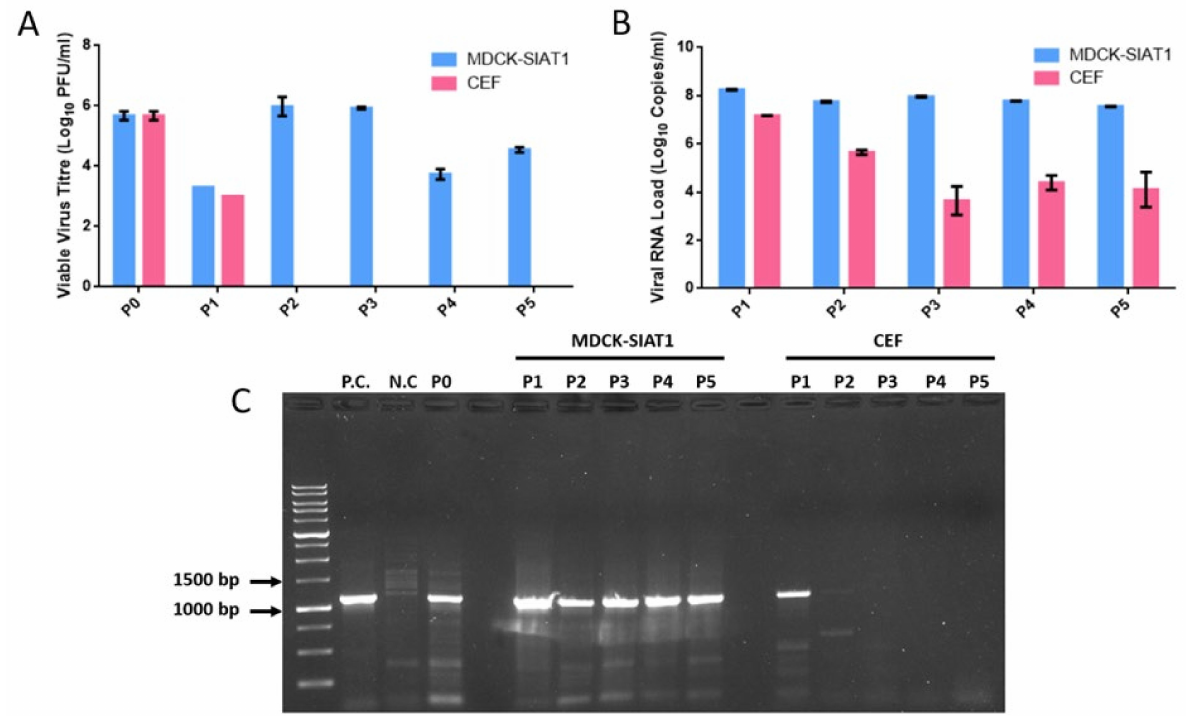
Figure 2. Viable A/Singapore/G2-31.1/2014 virus, total viral RNA quantification, and classical HA1 RT-PCR amplification of serial passage samples. ( A ) Live virus titers in the MDCK-SIAT1 and CEF passages at the day of harvest. Data represent mean values derived from duplicates. ( B ) Total viral RNA quantification in each MDCK-SIAT1 and CEF passage. Data represent mean values derived from triplicate analyses. ( C ) Screening of MDCK-SIAT1 and CEF passages for the detection of